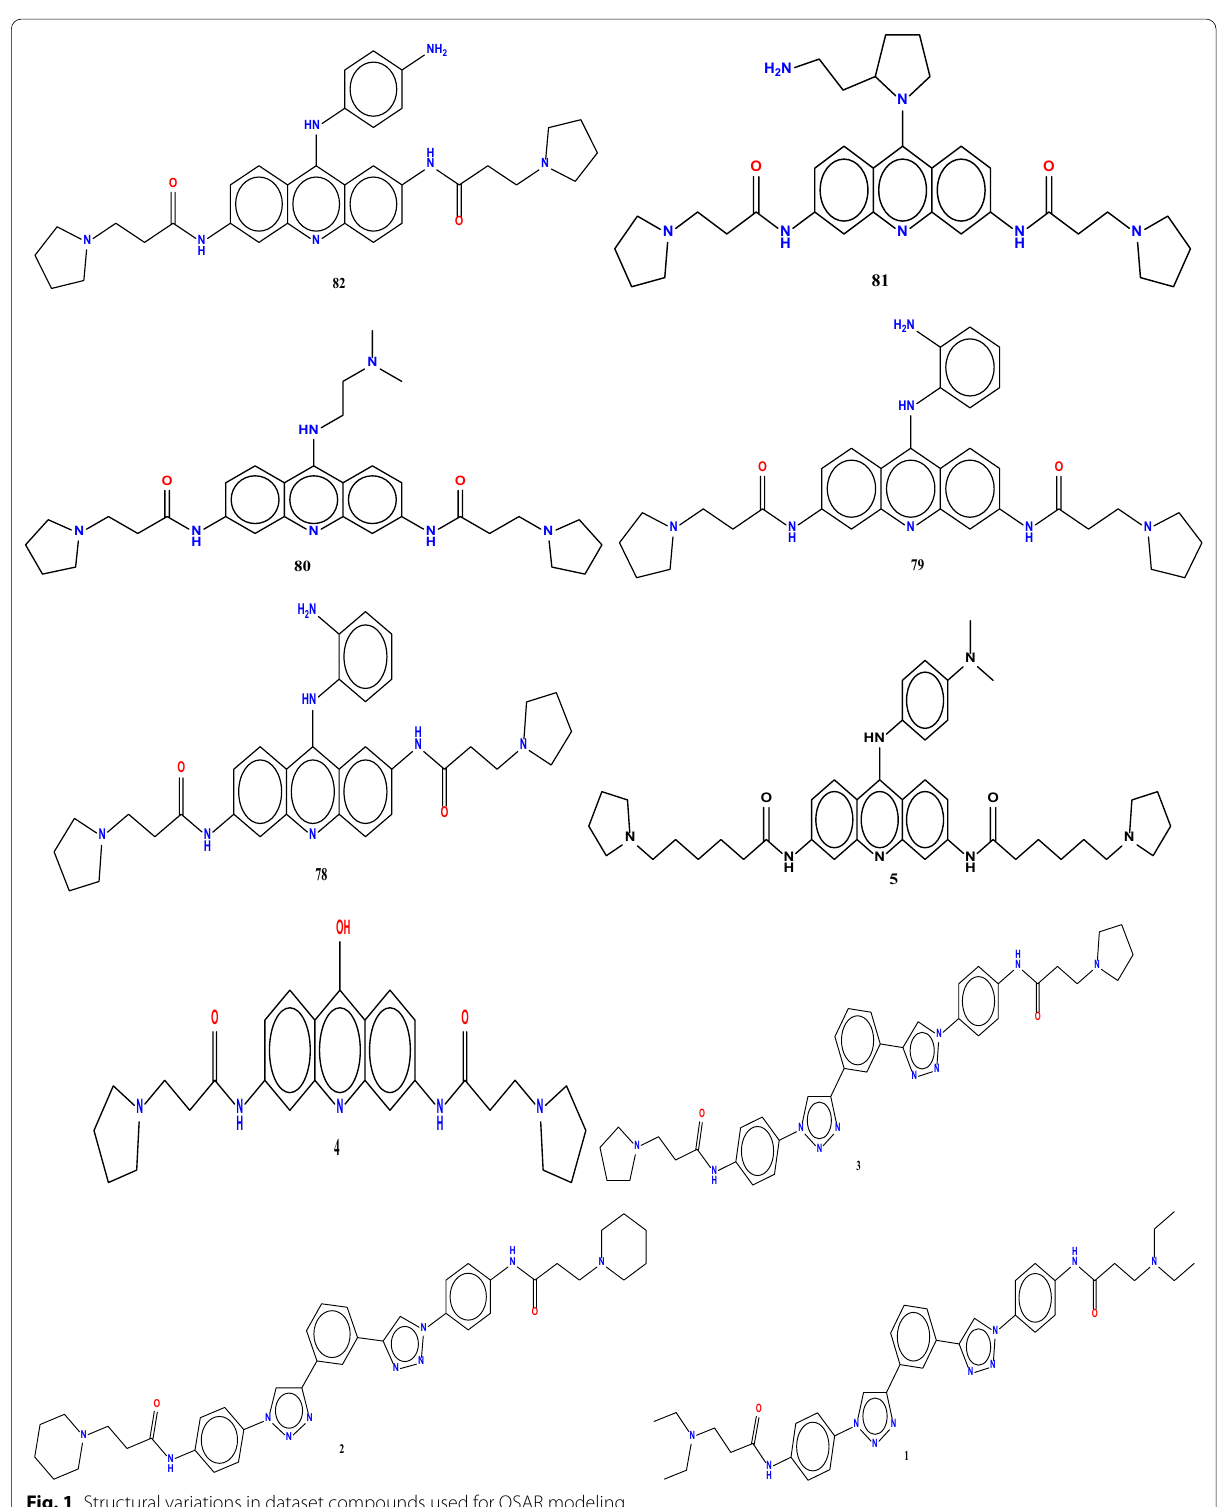
Fig. 1 Structural variations in dataset compounds used for QSAR